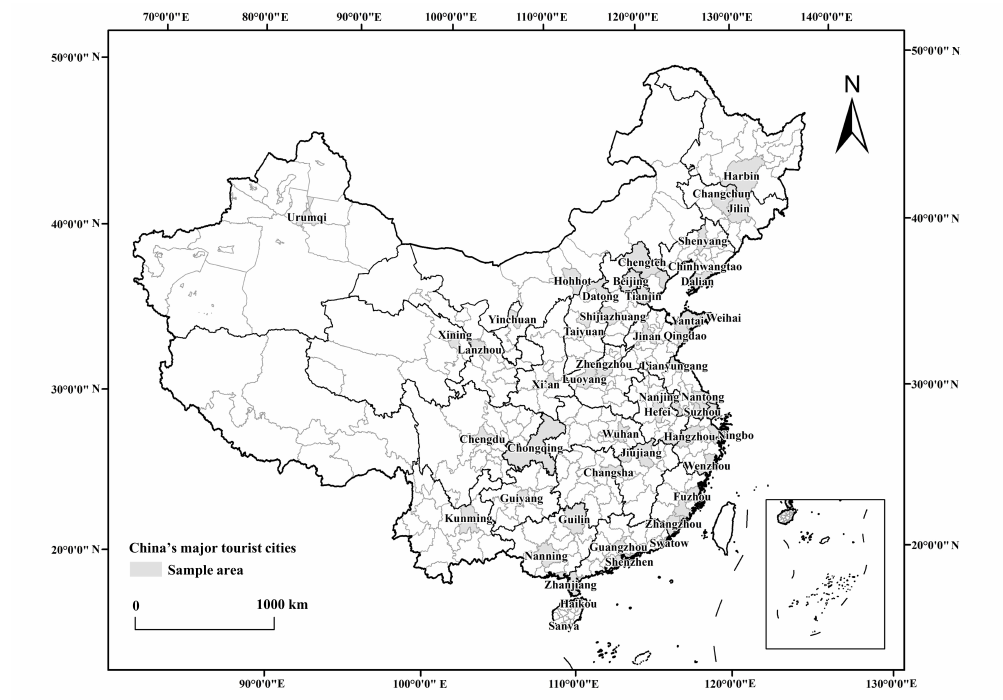
Figure 1. Spatial distribution of major tourist cities in